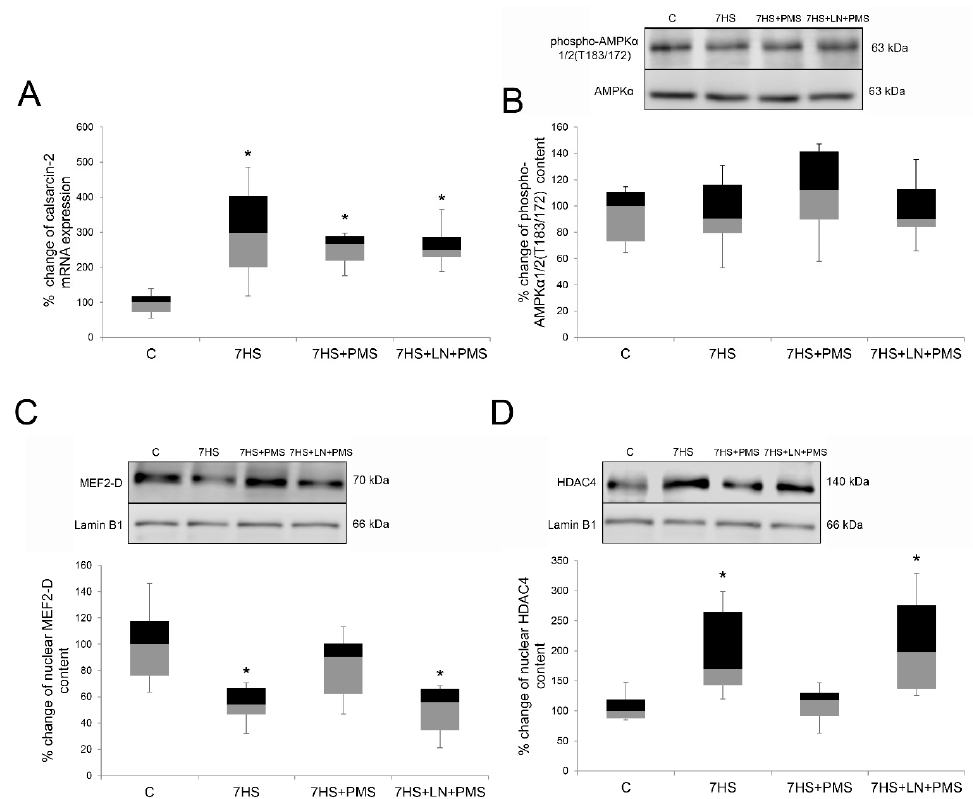
Figure 6. Expression level of calsarcin-2 mRNA ( A ), Western-blot analysis of phospho-AMPK α 1/2(T183/172) content ( B ), Western-blot analysis of MEF2-D ( C ) and HDAC4 ( D ) nuclear content in rat soleus muscle in control group (C), 7-day hindlimb-suspended group (7HS), 7-day hindlimb suspended group with plantar mechanical stimulation (7HS + PMS), 7-day hindlimb suspended group with plantar mechanical stimulation+ L-NAME introduction (7HS + LN + PMS). Data shown as % of the control group. *—significant difference from the control group. &—significant difference from 7HS group ( p < 0.05). Box plots show 25–75 percentiles and median values and the whiskers represent the minimum and the maximum; n = 8/group.